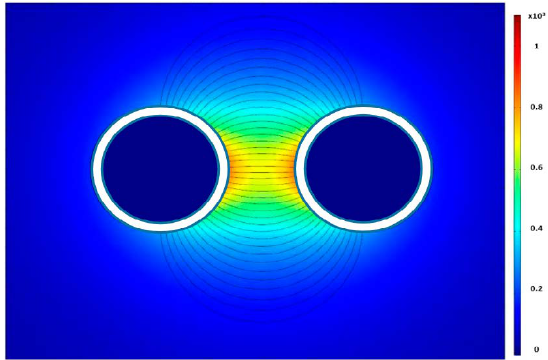
Figure 9. Capacitance contour plot of two parallel cylindrical capacitors.